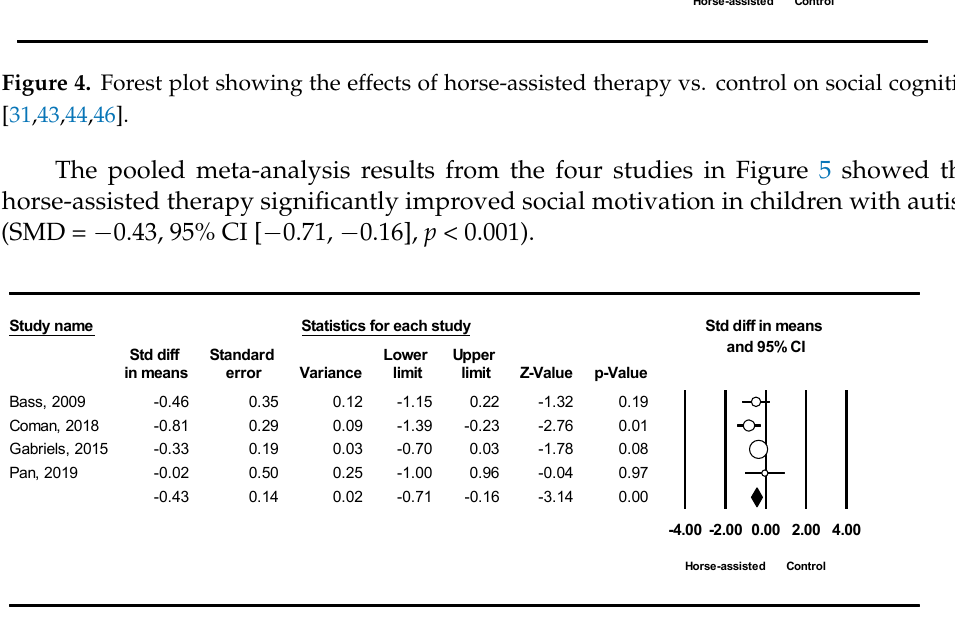
Figure 5. Forest plot showing the effects of horse-assisted therapy vs. control on social motivation [31,43,44,46].